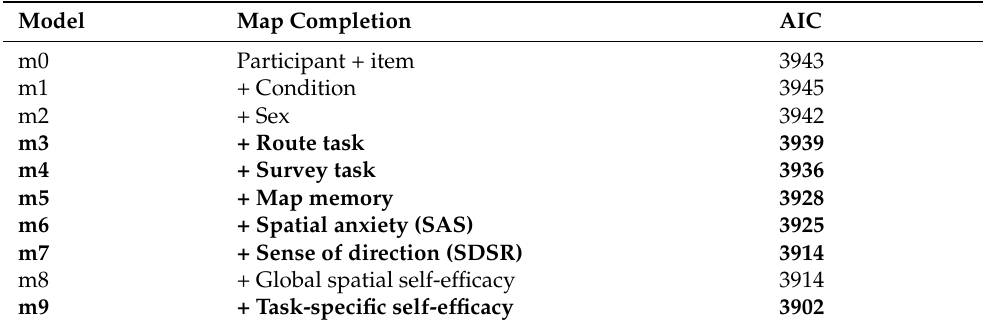
Table 4. Map completion: stepwise model selection results. Variables that decreased AIC appear in